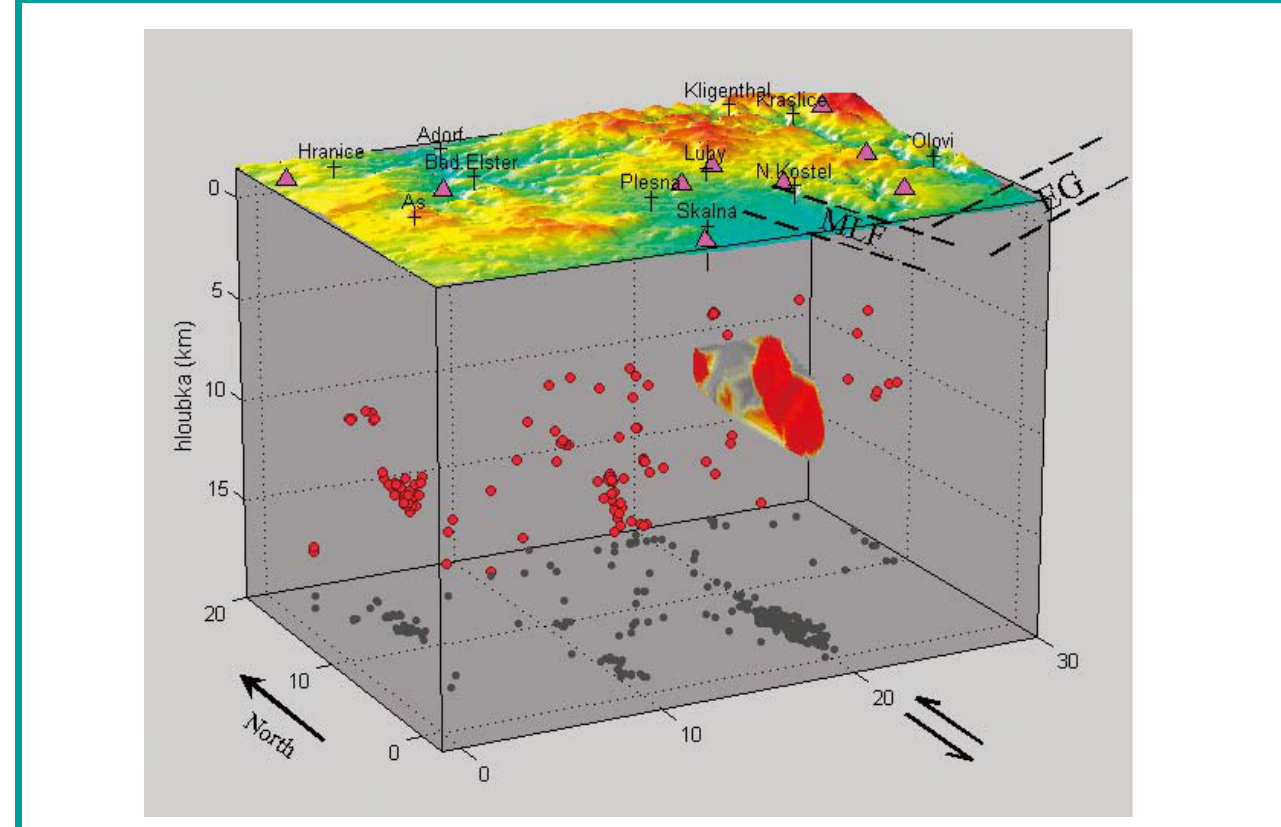
Figure 2. Schematic 3-D section of the Nový Kostel area. The main epicentral cluster indicated by red surface occurs at depths of 6-11 km below the eastern margin of the Cheb Basin. Triangles indicate seismic stations of WEBNET. EG and MLF denote the main tectonic structures of Eger Rift and Mariánské Lázn ě